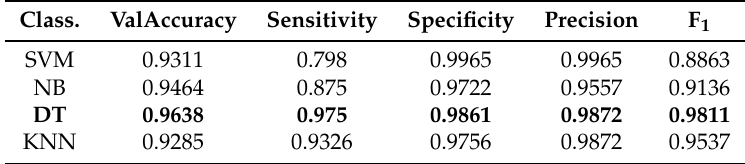
Table 3. Performance measures of different classifiers used to distinguish the healthy population from PD patients.